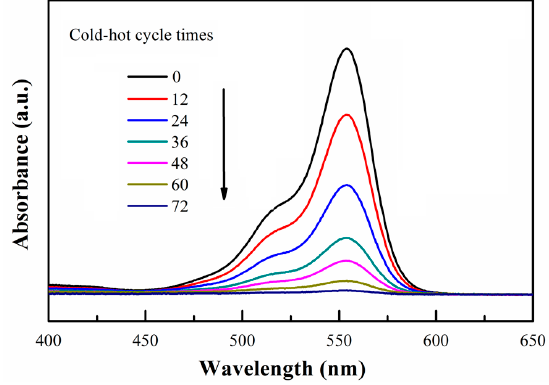
Figure 4. The adsorption spectra of RhB after performing different numbers of cold–hot cycle excitations.